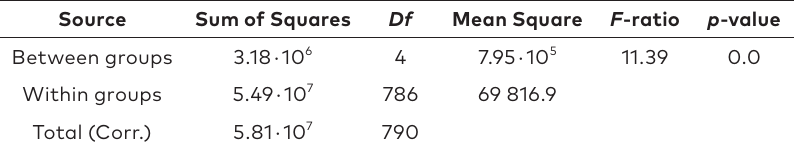
Figure 21. Box-and-whisker plot. ANOVA analysis